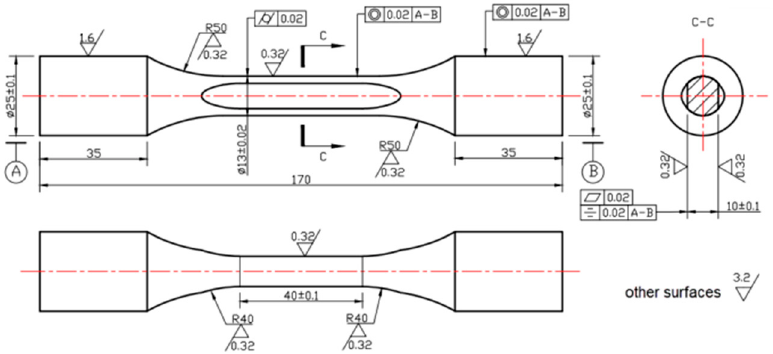
Figure 4. Dimensioned design drawings for the fretting specimen; dimensions are in mm.